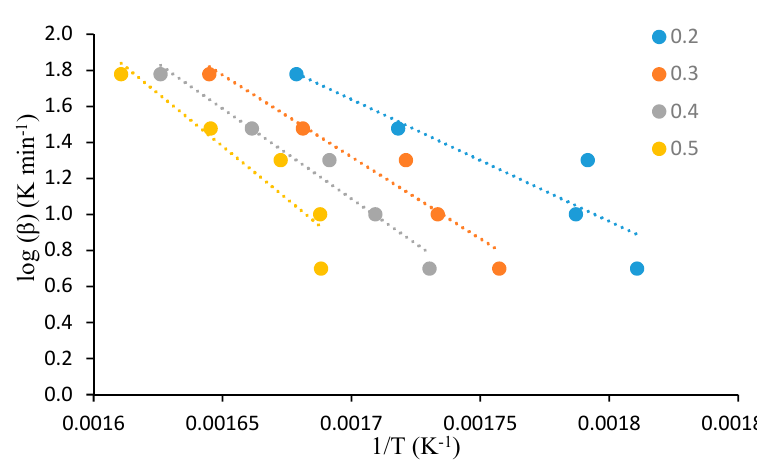
Figure 4. A plot of log β vs. 1/ T at various α values (given as the inset) for tamarind.